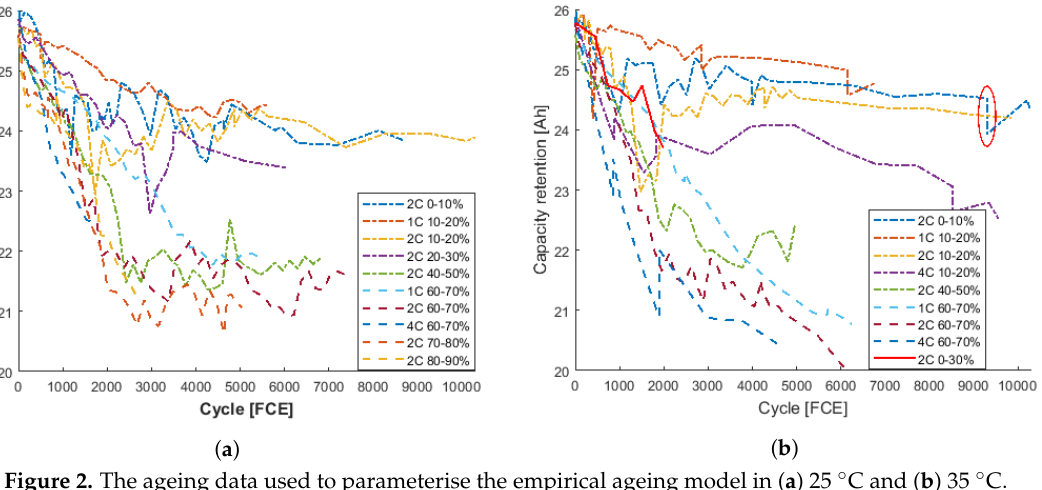
Figure 2. The ageing data used to parameterise the empirical ageing model in ( a ) 25 ◦ C and ( b ) 35 ◦ C. In ( b ), the data is also used to verify the model included. The vertical changes in capacity indicates stops in the testing due to maintenance, i.e., a rest